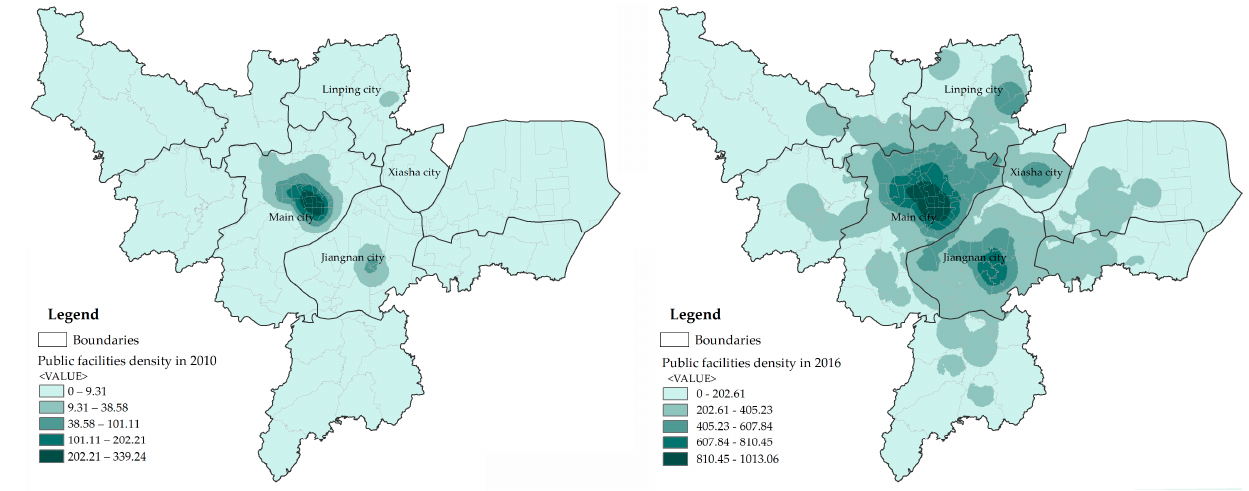
Figure 4. Public facilities density in Hangzhou in different years.